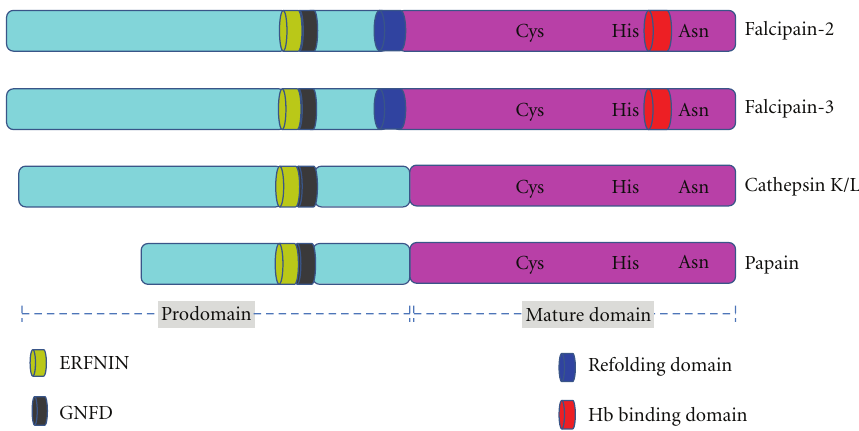
Figure 1: Falcipains have unique features. Falcipains are papain family cysteine proteases, active site residues (Cys, His, Asn) are conserved within the papain family, but falcipains have a unique N-terminal extension acting as a refolding domain, and a C-terminal insert as a hemoglobin (Hb) binding domain. Prodomain has ERFNIN and GNFD motifs, conserved in falcipains, papain, and